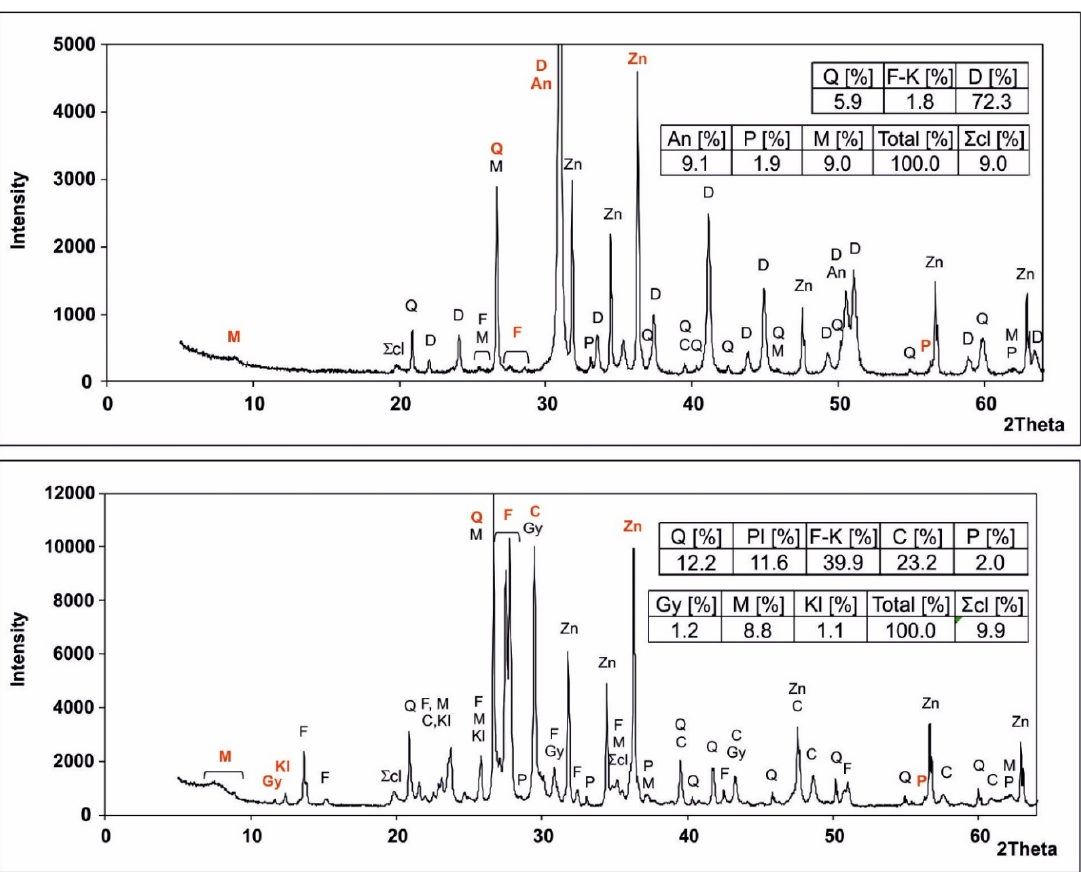
Figure 10. Exemplary diffraction patterns for samples from the Biesiekierz-2 borehole. An example of a typical carbonate (upper) and arkosic sandstone (lower) sample. Explanations: Q—quartz; F—feldspars; Pl—plagioclase; F-K—potassium feldspars; C—calcite; D—dolomite; An—ankerite; Gy— gypsum; M—micas and illite group clay minerals; Kl—kaolinite; Σcl—sum of clay minerals, Zn—